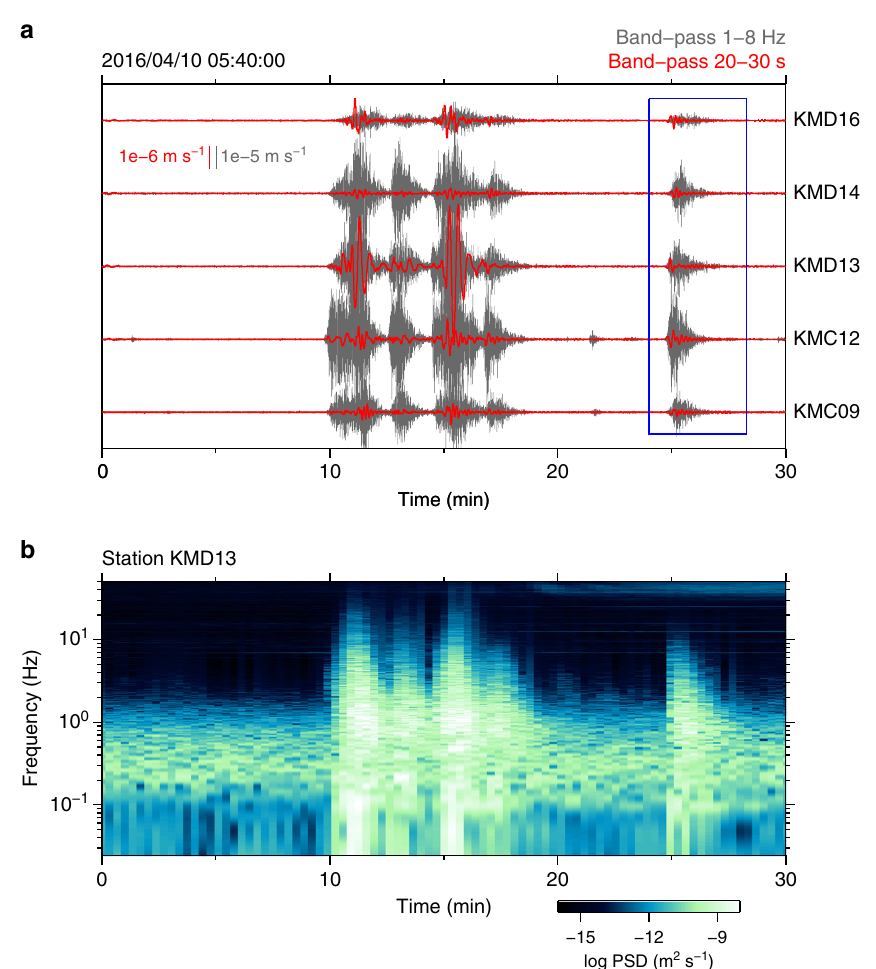
Fig. 2 An example of sVLFE burst activity in vertical component seismograms. a Gray and red waveforms represent short-period (band-passed 1 – 8 Hz) and long-period (band-passed 20 – 30 s) components, respectively. The blue rectangle outlines the sVLFE for which the CMT inversion result is shown in Supplementary Fig. 2. b Running spectrum of the waveform observed at station KMD13, the middle waveform in